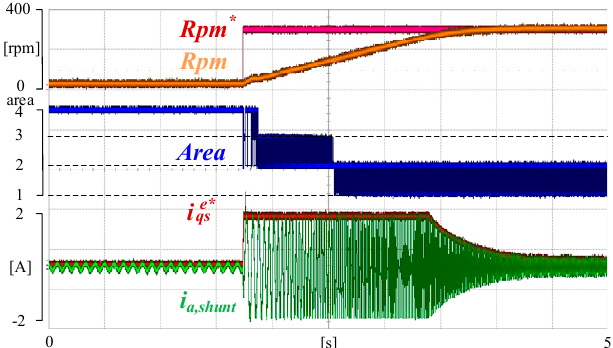
Figure 18. The phase current sampled through the shunt resistor when the step response is induced in Area 4.